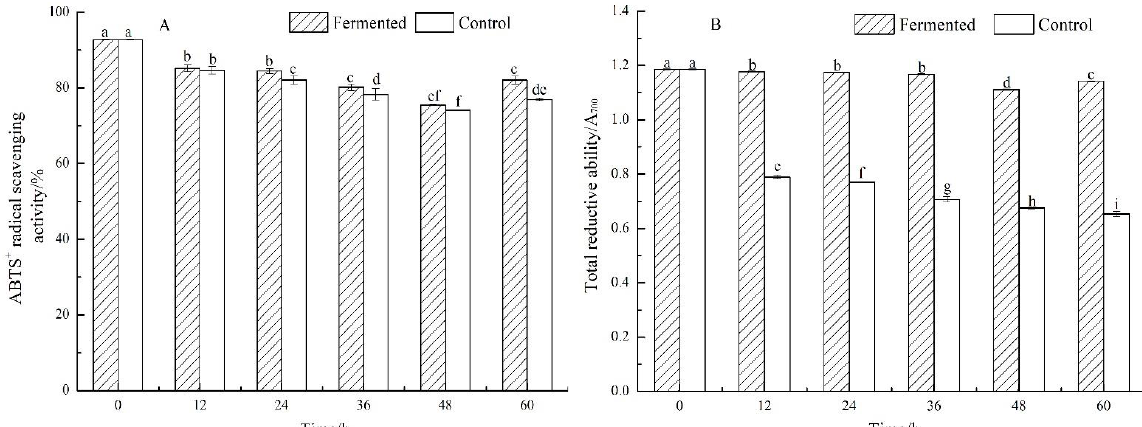
Figure 2. ABTS + radical scavenging activity ( A ) and total reductive ability ( B ) of fermented and control lemon juice. Bars marked with different superscript lowercase letters ( a–i ) within the different periods (0 h–60 h) indicate the significant difference ( p < 0.05) between fermented and control.